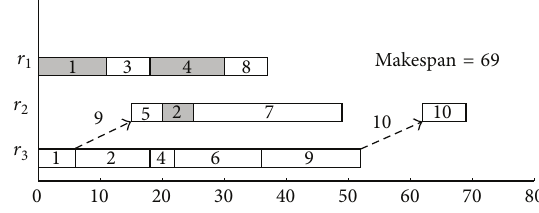
Figure 3: Schedule of task graph with the HCPPEFT algorithm.